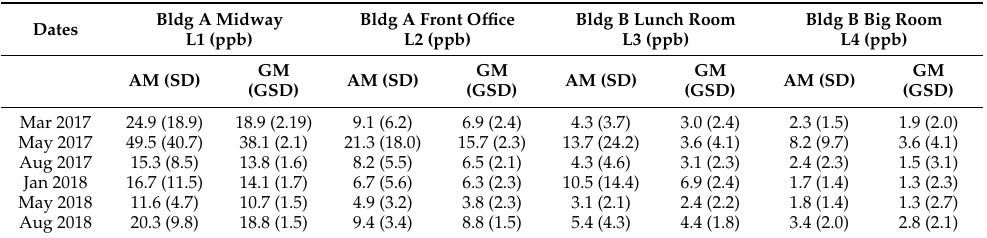
Table 2. Mean and Standard Deviation of indoor concentrations of TCE from 24 h samples at each location for each sampling event.